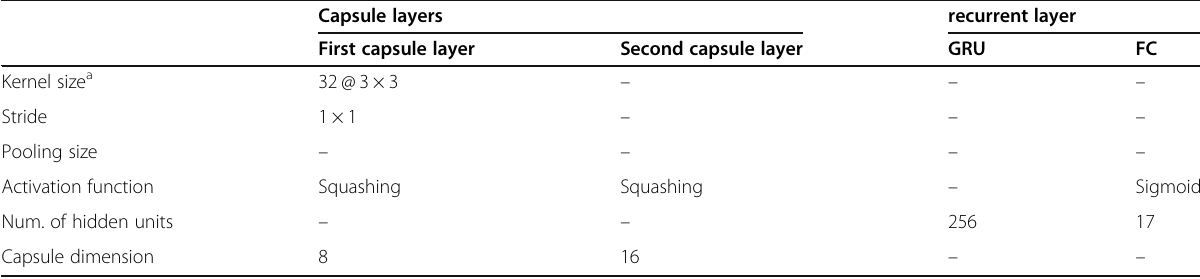
Table 3 Model parameters (capsule layers, recurrent layer)